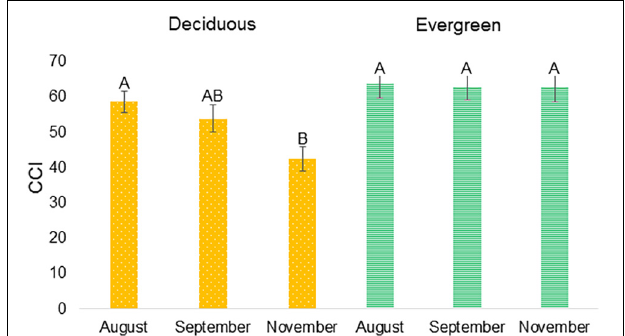
FIGURE 9 | Chlorophyll content index (CCI) of deciduous and evergreen pomegranates at three dates. CCI was measured at 24.8.2016, 25.9.2016, and 9.11.2016 for deciduous (Orange, dots) P.G.100-1 and nine deciduous F3 descendants of ’P.G.160-61 × Wonderful’ population and for evergreen (Green, stripes) P.G.160-61 and nine evergreen F3 progeny. Letters represent significantly differences by comparisons for each pair using Student’s t